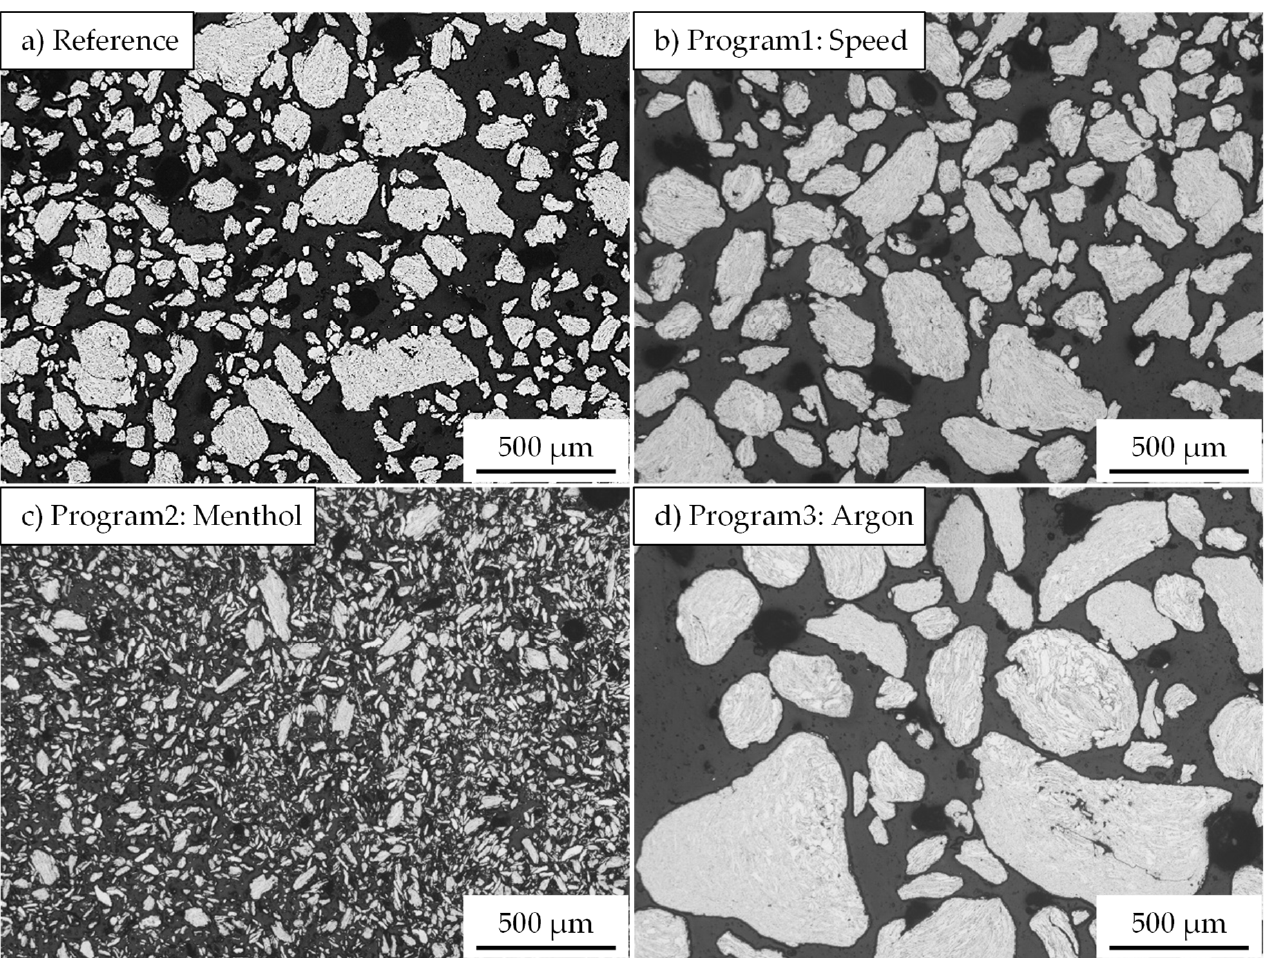
Figure 5. Influence of different milling programs ( a ) Reference, ( b ) Program1 with speed change, ( c ) Porgramm2 with menthol as PCA, and ( d ) Program3 with argon atmosphere on the size and the shape of the HEBM composite powder .